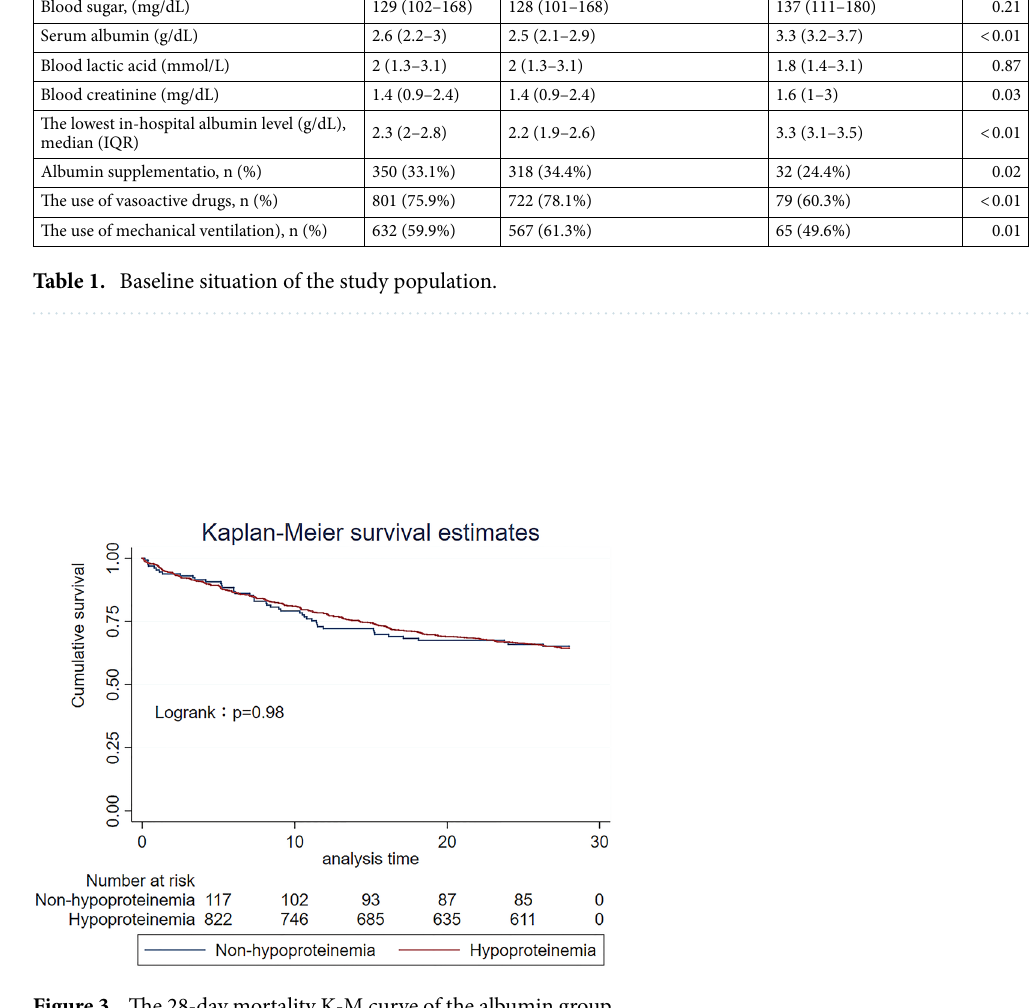
Figure 3. The 28-day mortality K-M curve of the albumin